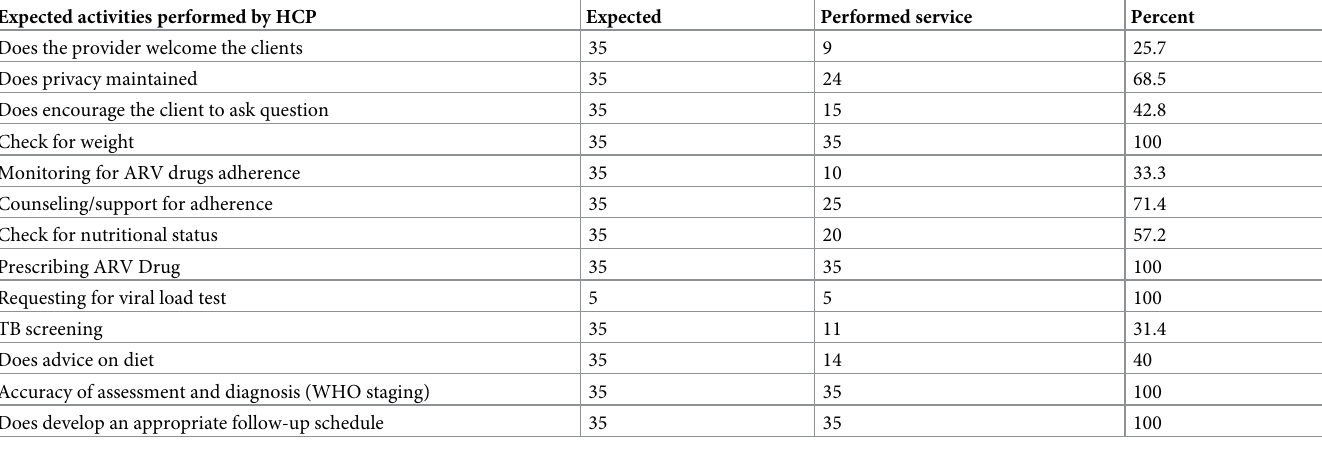
Table 3. Participatory observation result of healthcare provider performance in GCAHCs, April 2020. Expected activities performed by